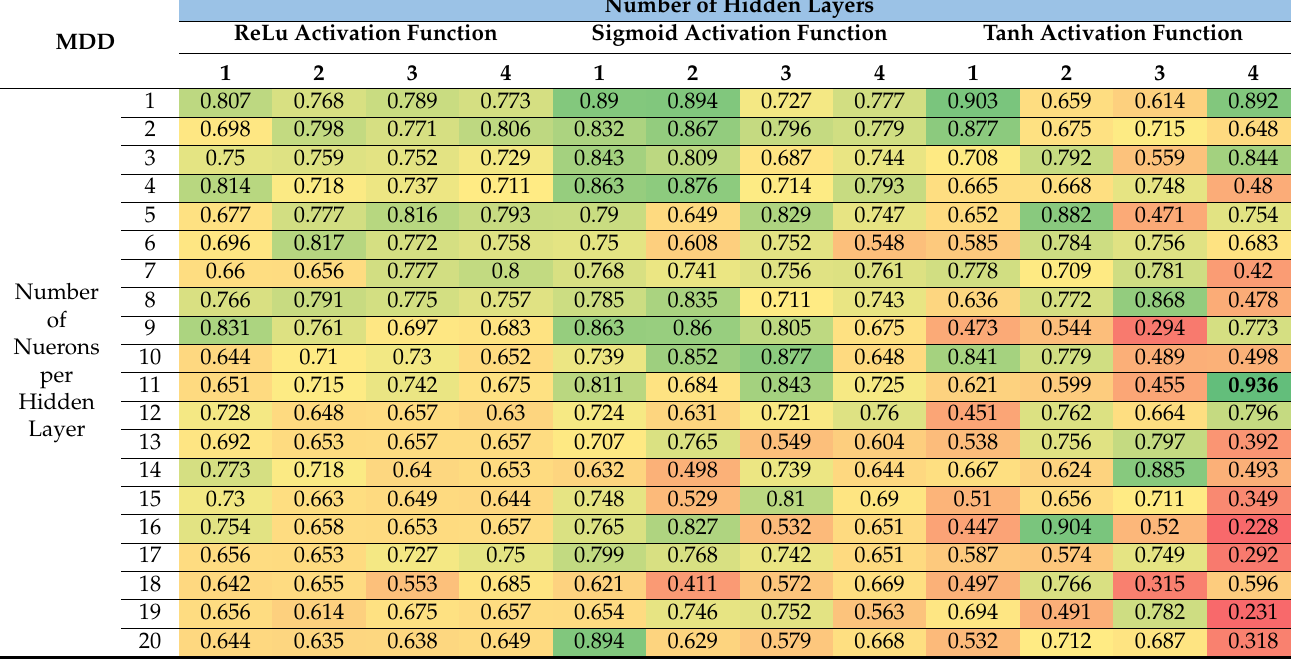
Table 2. R 2 values of the testing set for every ANN in the prediction of the MDD.